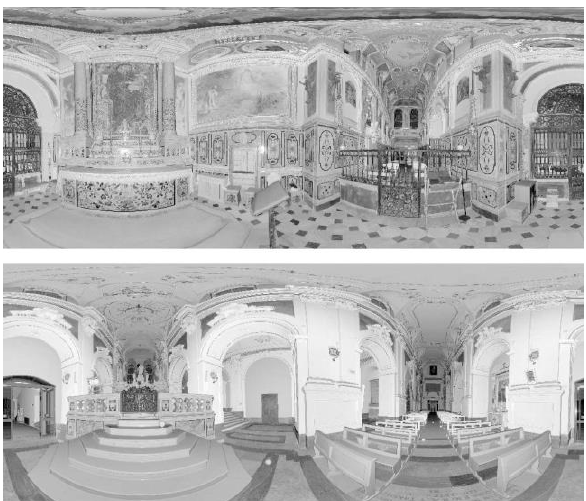
Figure 14. Equirectangular photographs taken by the